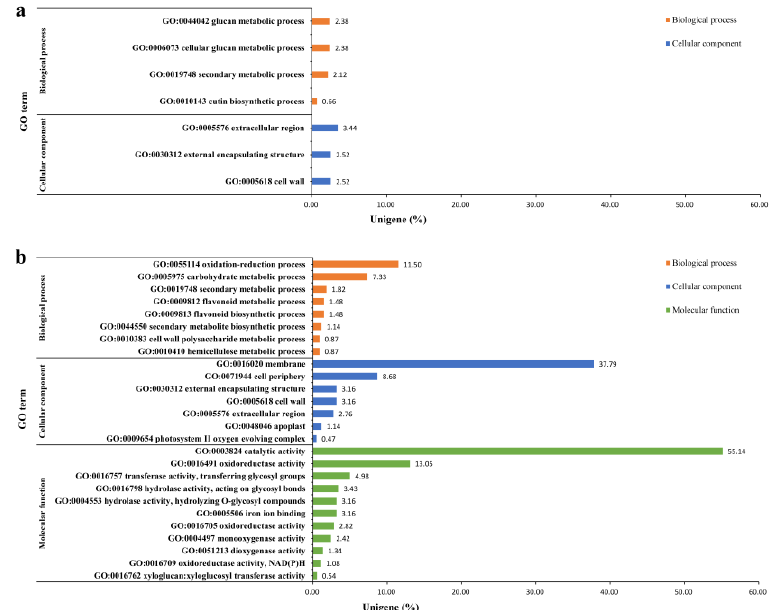
Figure 3. Gene Ontology (GO) enrichment test of cultivars LJ43 ( a ) and ZN139 ( b ). GO terms are divided into three catalogs, i.e., molecular function (green bars), biological processes (orange bars), cellular component (blue bars), which is shown in Y -axis. X -axis shows the percentage of unigenes in all DEGs aligned to the GO database with Corrected p -value ( p ) < 0.05.